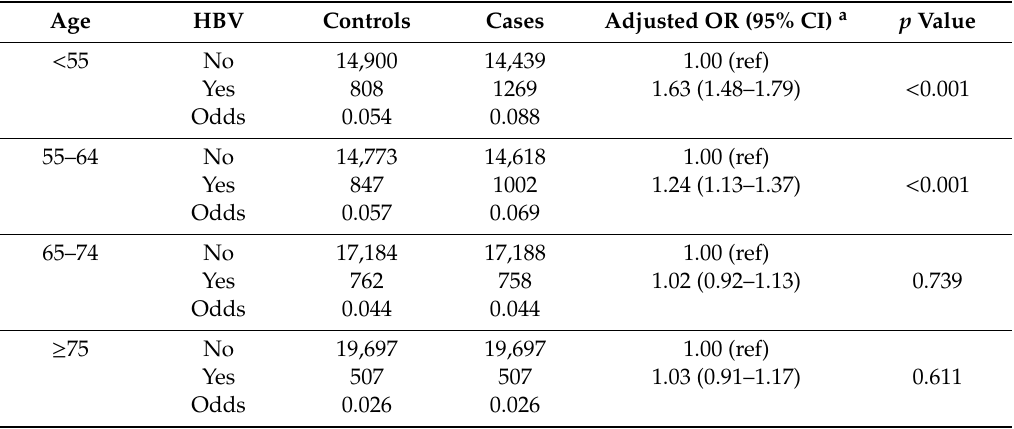
Table 3. Age-specific odds of chronic hepatitis B virus infection and case-to-control adjusted odds ratio of the infection.